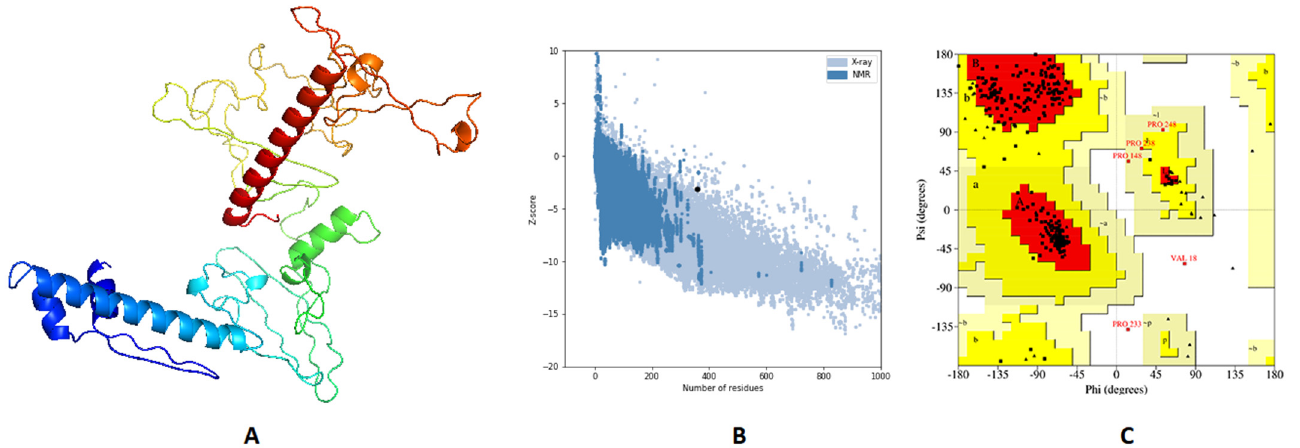
Figure 5. Structural analysis of the predicted vaccine 3D structure. ( A ) The 3D structure of designed vaccine after refinement; ( B ) ProSA-web evaluation of the refined vaccine where the black dot shows the exact Z-score; ( C ) Ramachandran plot analysis of the refined vaccine.